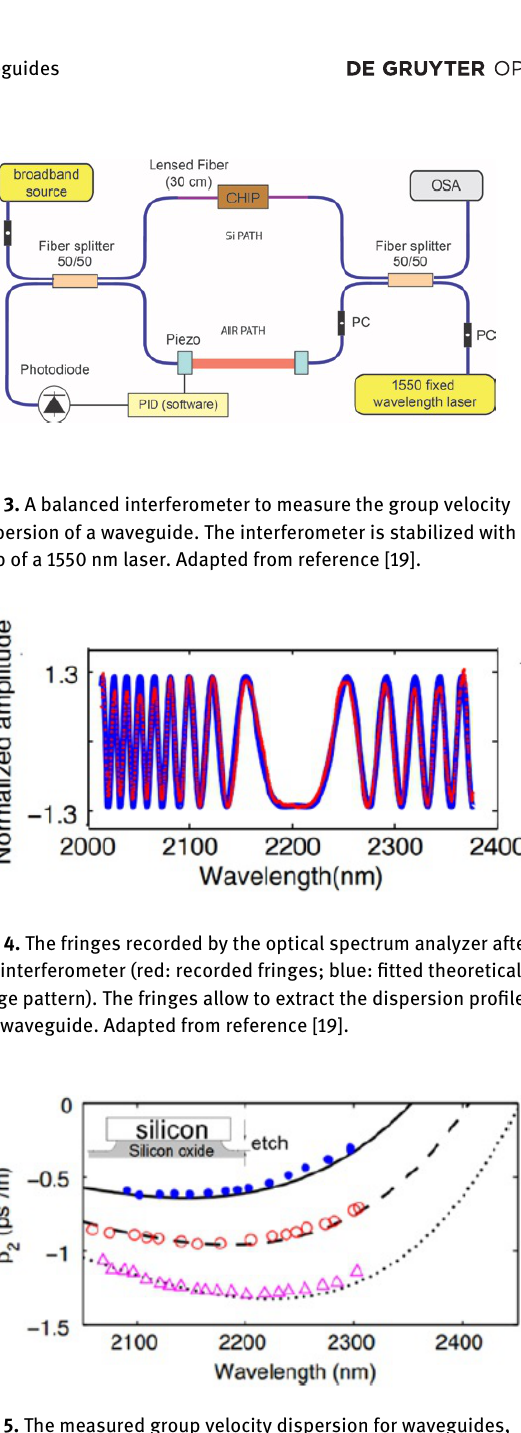
Fig. 5. The measured group velocity dispersion for waveguides, which are partially underetched by 0 nm (dots), 55 nm (circles) and 113 nm (triangles). Adapted from reference